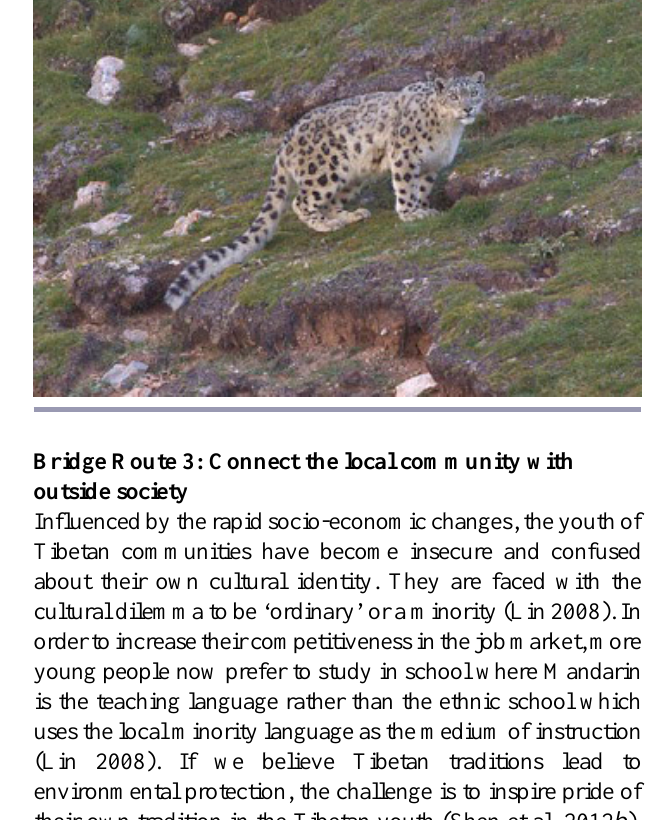
Fig. 4 . A snow leopard ( Uncia uncia ) encountered during the rapid biodiversity assessment in the Sanjiangyuan region in the summer of 2012. (Photo by Dong Lei)